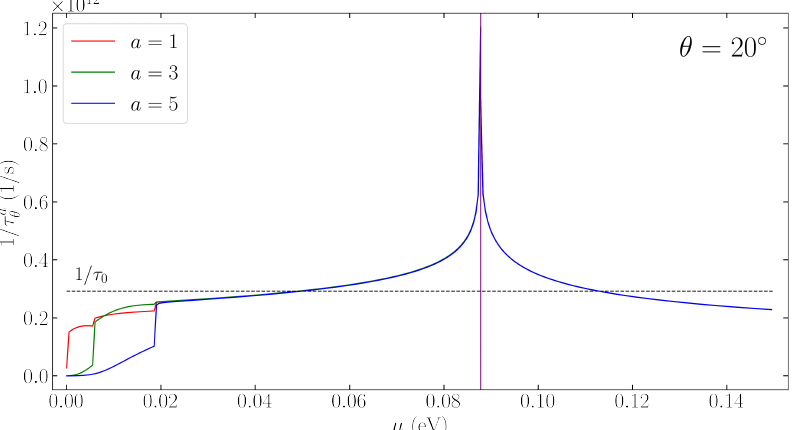
Figure A2. Graph of 1/ τ as a function of the chemical potential for a benchmark direction in the Brillouin zone. The dashed line corresponds to the inverse of the scattering time used in the main text. The purple vertical line corresponds to the energy at which a Lifshitz transition occurs for first band (see Figure A3). The results obtained using a temperature of T = 10 K are shown in Figure A3.